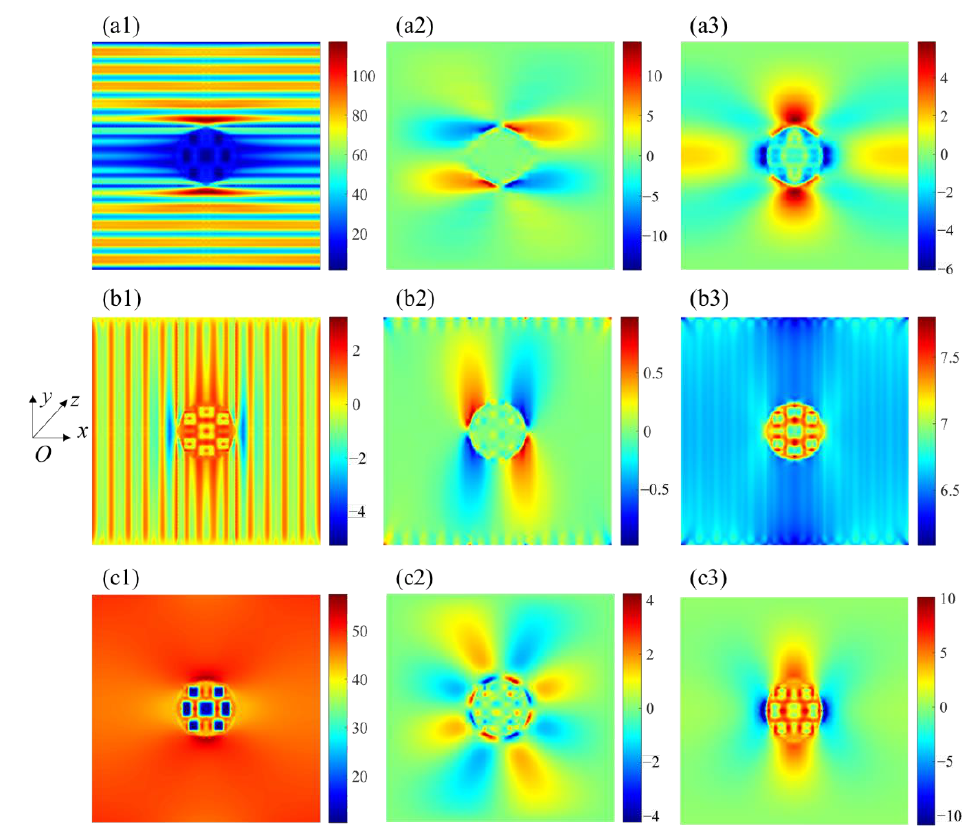
Figure 8. Stress contour for needling region: ( a1 ) σ 11 , ( a2 ) σ 12 and ( a3 ) σ 22 for 0° unidirectional fibers; ( b1 ) σ 11 , ( b2 ) σ 12 and ( b3 ) σ 22 for 90° unidirectional fibers; ( c1 ) σ 11 , ( c2 ) σ 12 and ( c3 ) σ 22 for short-cut fibers (unit: MPa).